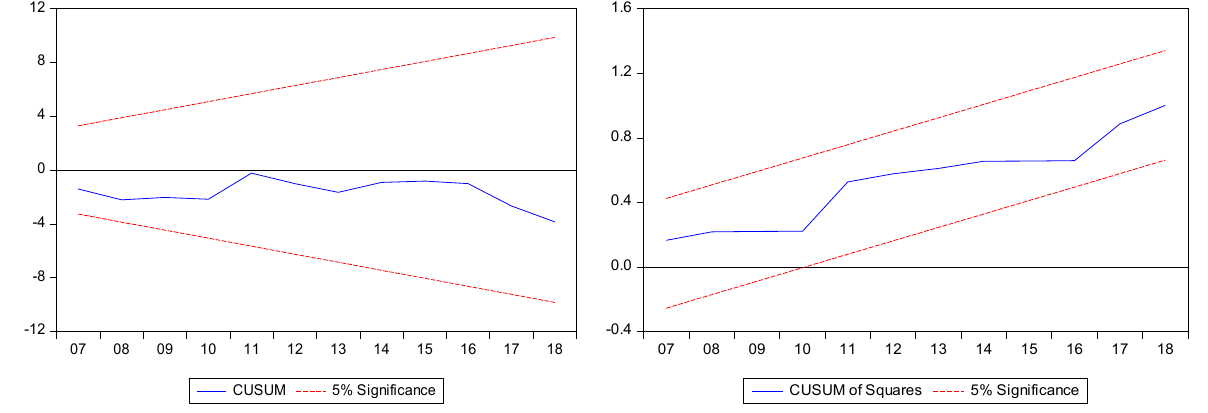
Figure 8. NARDL CUSUM and CUSUM of Square.